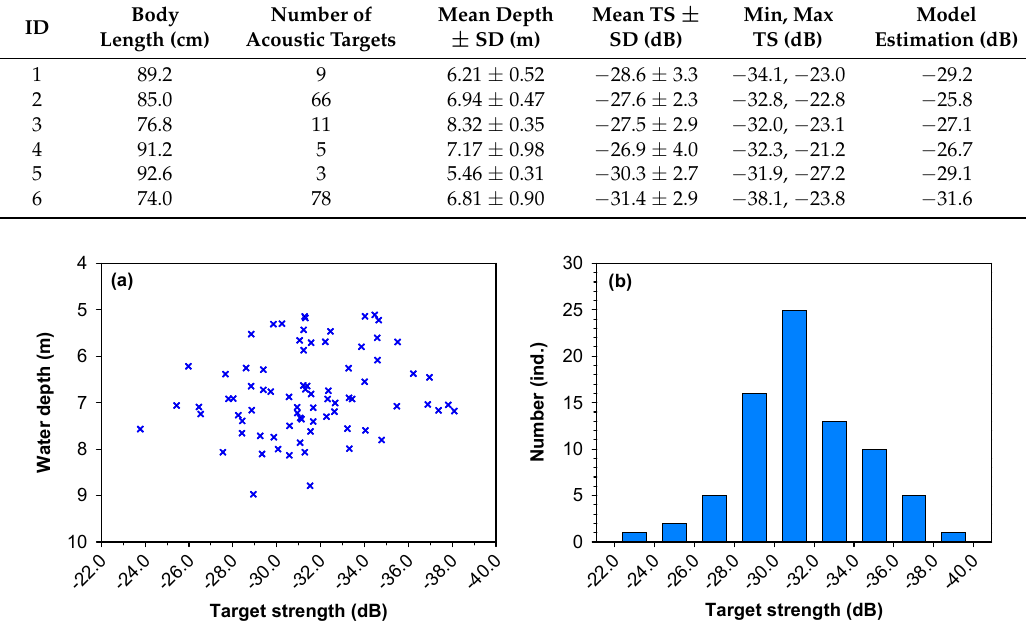
Table 4 . Results from the ex situ measurements and the theoretical calculations. Table 4. Results from the ex situ measurements and the theoretical calculations.